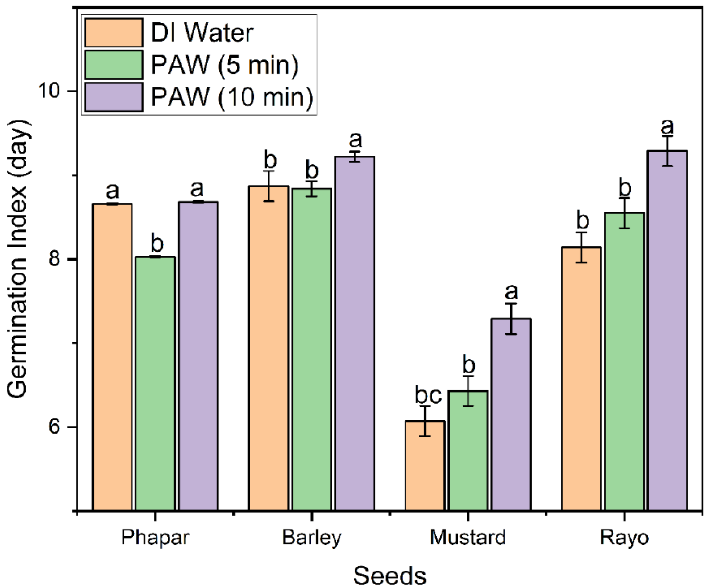
Figure 9. Effect of DI and PAW on the germination index (GI) of seeds. Different letters (a–c) indicate significant differences at p < 0.05 level among all treatments as determined by Tukey’s multiple comparison test.